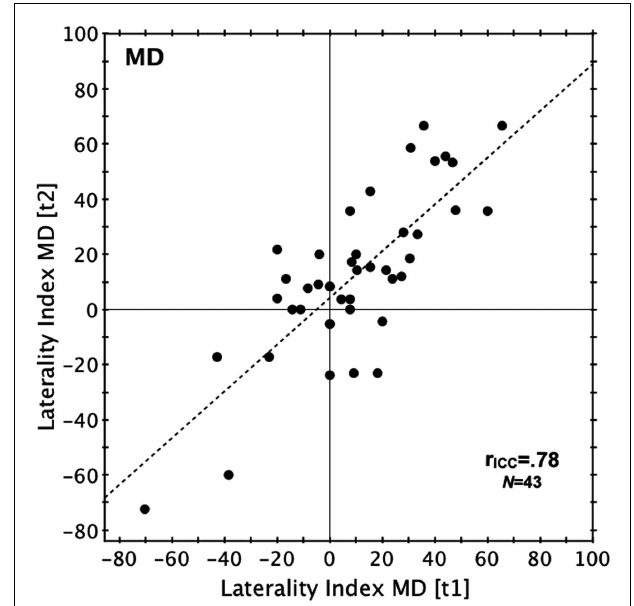
FIGURE 2 | Reliability (Australian sample). Scatterplot relating the LI of the first and second test run in the Australian sample. Laterality index, percentage difference between correct LE and RE reports. r ICC , intraclass correlation